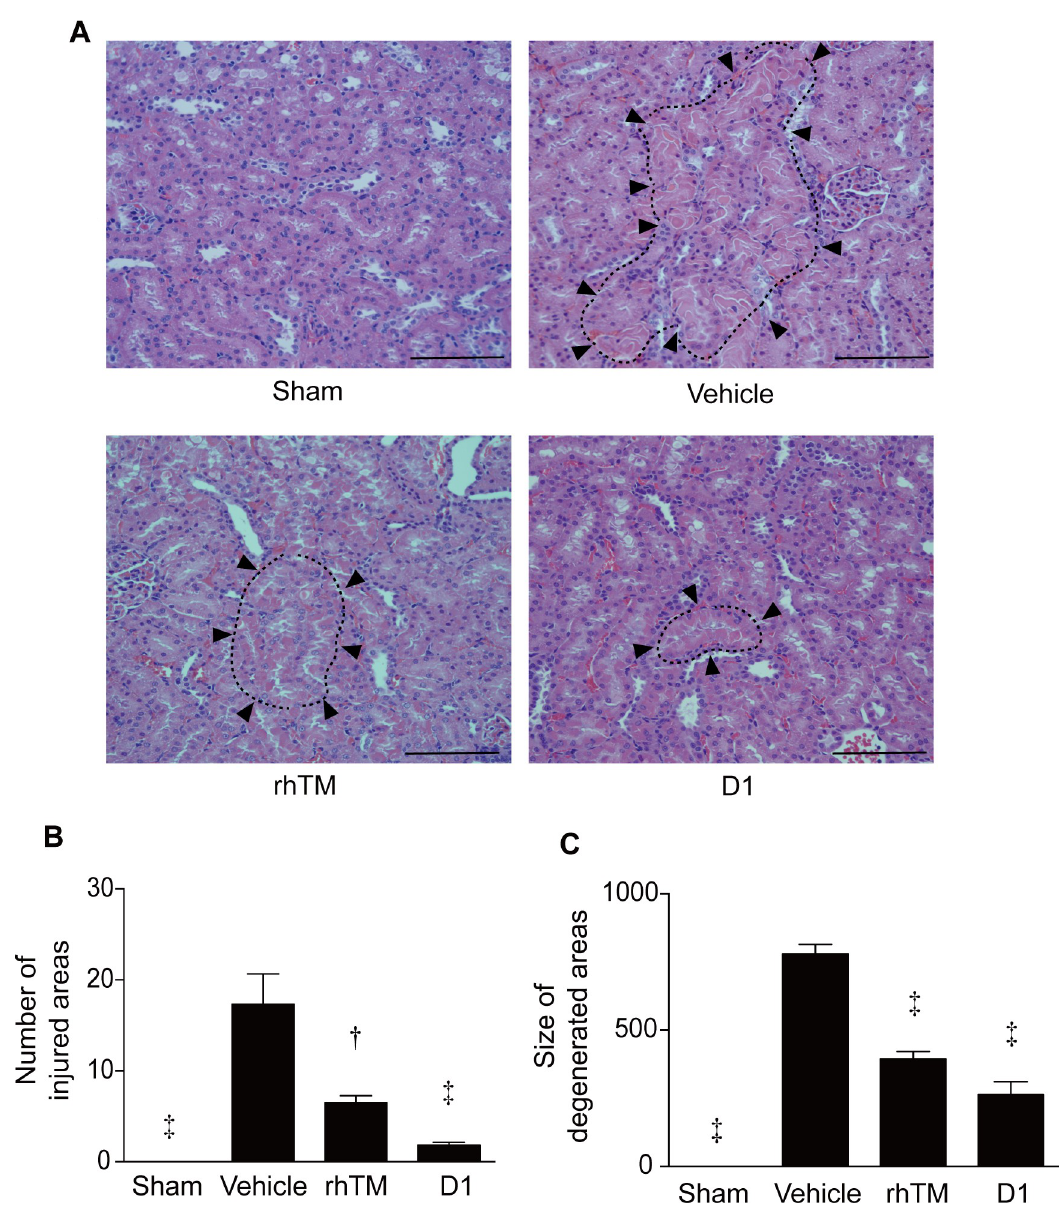
Fig 5. Histopathologic examination of kidney stained with HE. A) Histologic findings in rat kidney. Renal tissue was obtained 16 h after CLP and stained with HE. Arrowheads indicate degenerated areas. Representative images are shown at a magnification of × 200. B) Quantification of kidney degeneration in the four groups is shown (number of injured areas). n = 6 per group. C) Quantification of kidney degeneration in the four groups (size of degenerated areas). n = 6 per group. † P � 0.01 vs. vehicle. ‡ P � 0.001 vs. vehicle. Scale bars = 200 μ